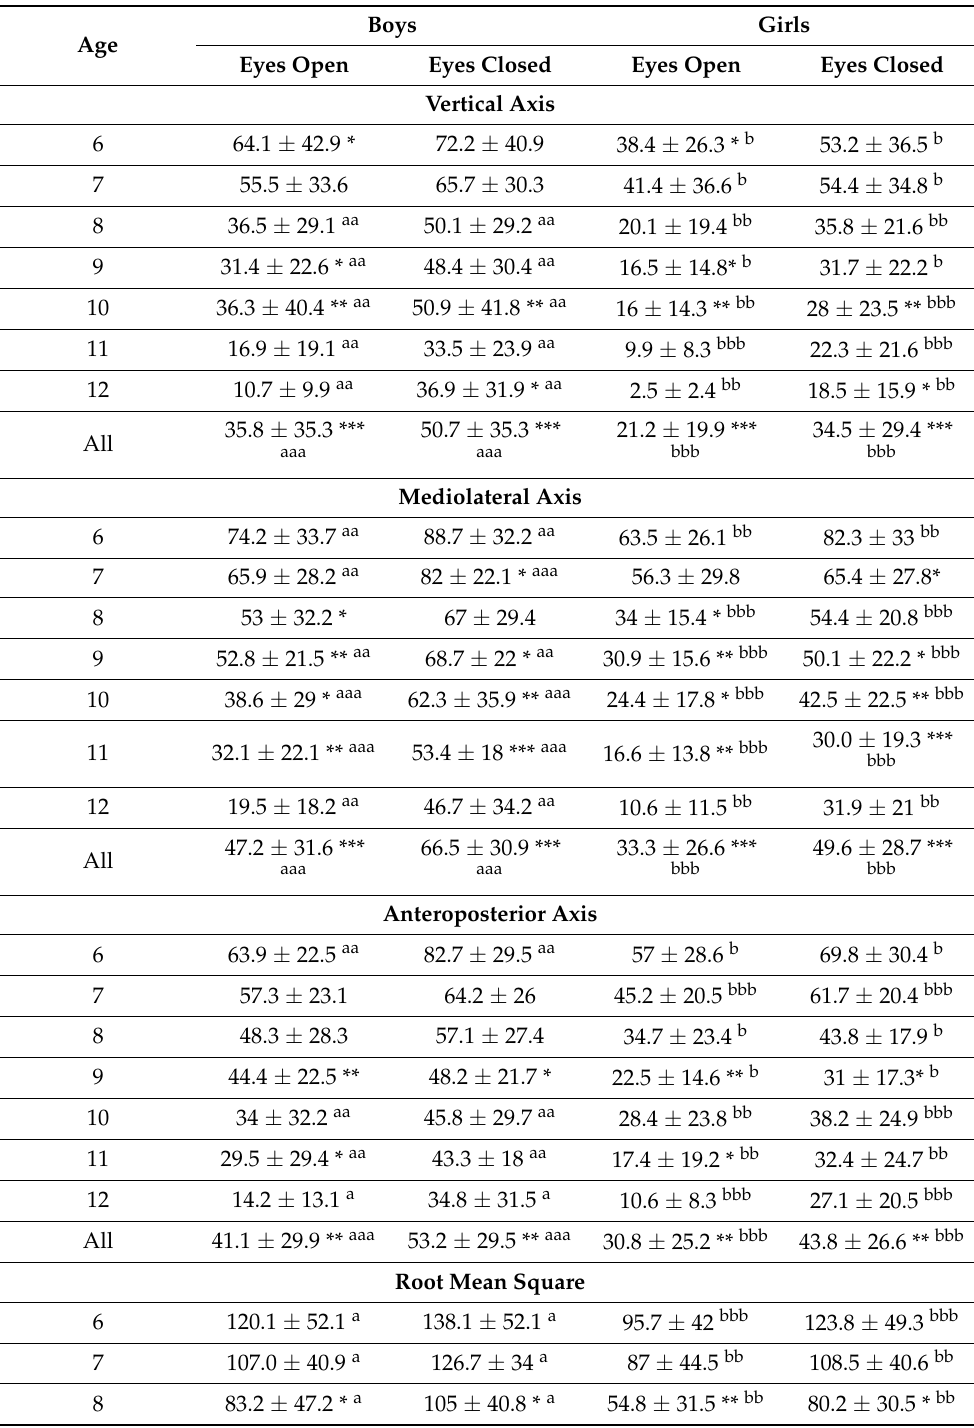
Table 3. Maximum acceleration during monopodal test with eyes open and eyes closed (mean ± standard